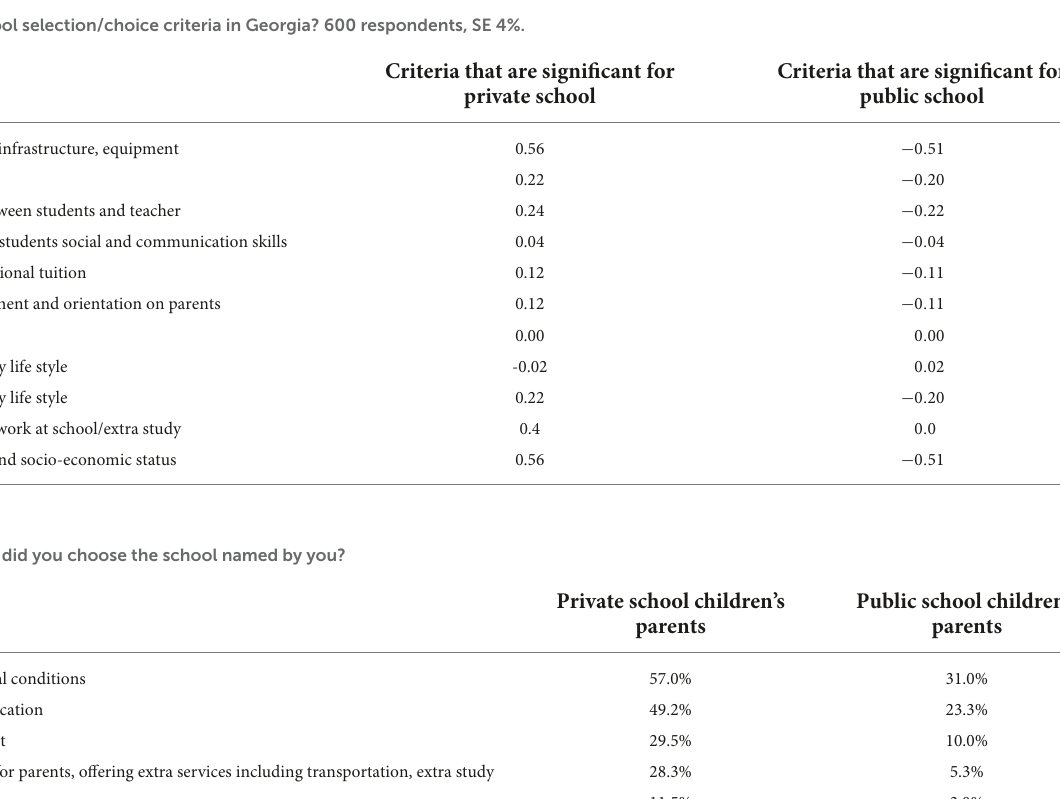
TABLE 8 School selection/choice criteria in Georgia? 600 respondents, SE 4%.